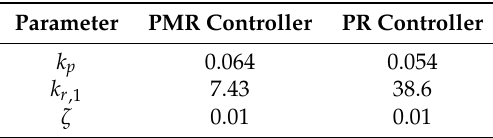
Table 2. Table 2. Parameters of the tested Table 2. Parameters of the tested controllers.